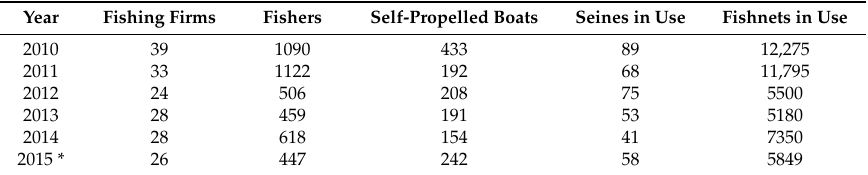
Table 5. Fishing employment and fleet on Lake Balkhash 2010–2015. * data based on 8 months of observation. (Source: Kazakh Research Institute of